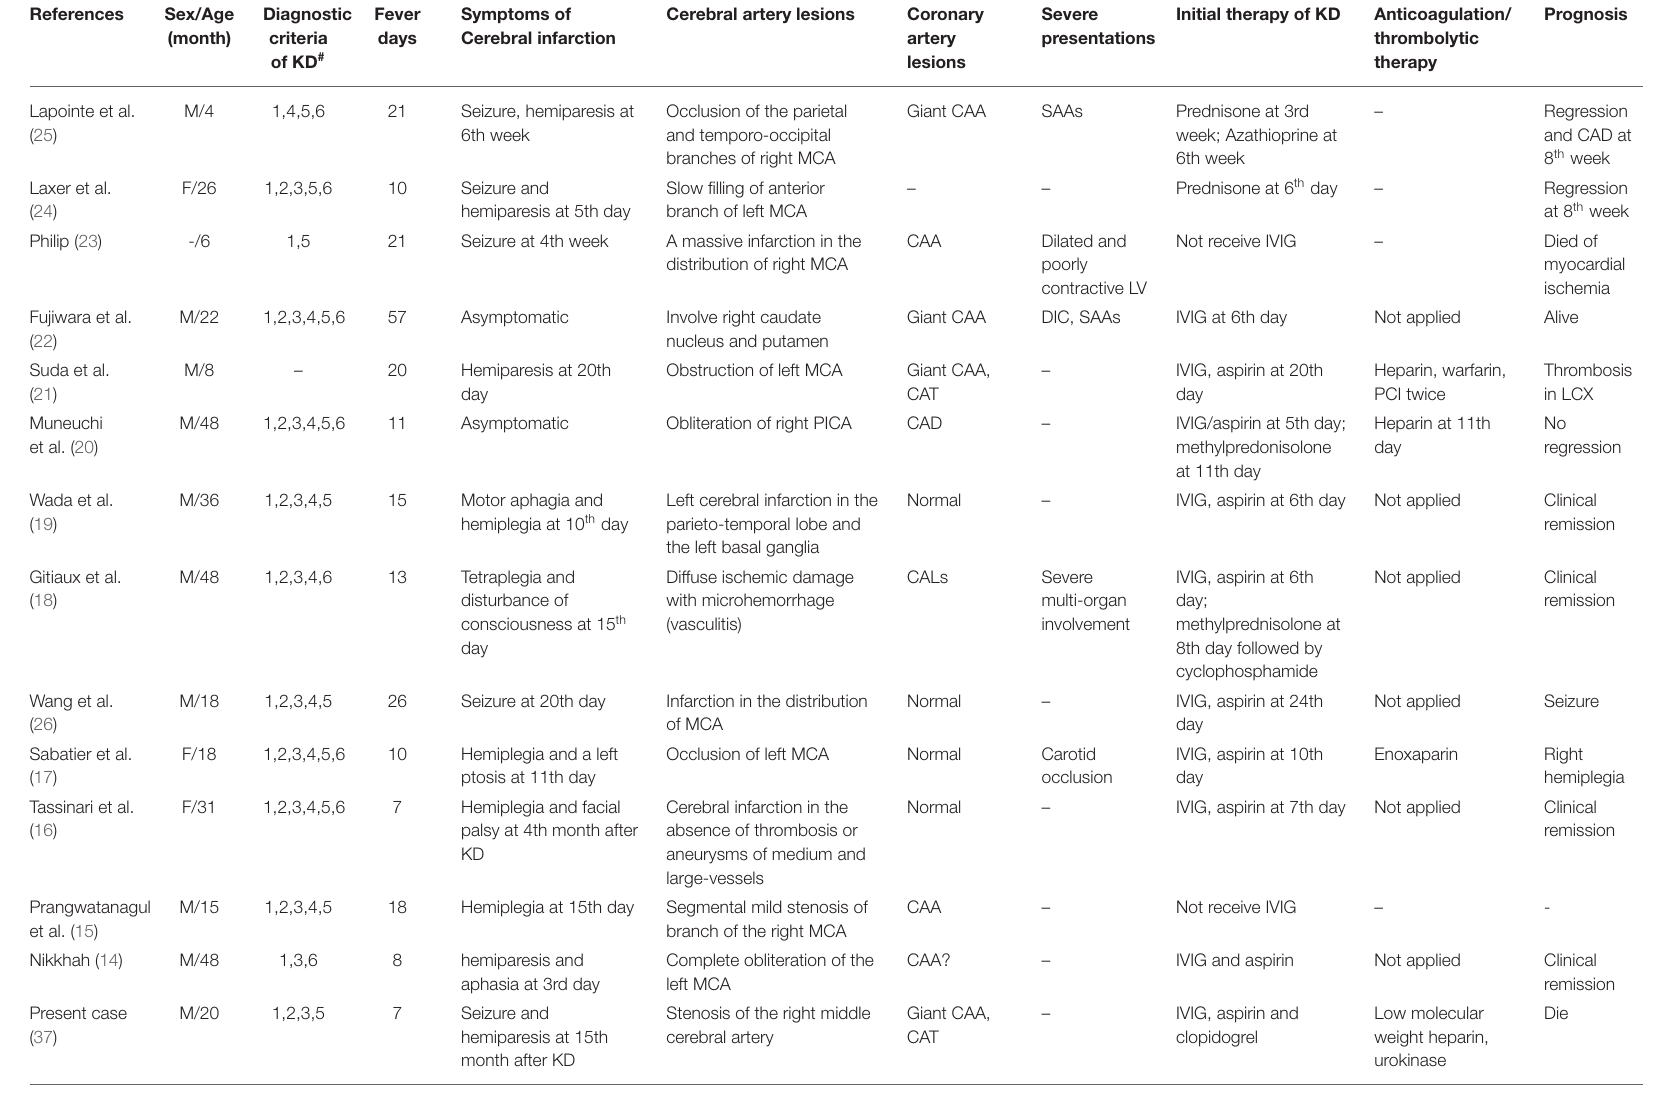
# DiagnosticcriteriaofKDincludes1.Feverforatleast5days;2.Bilateralbulbarconjunctivalinjectionwithoutexudate;3.Changesinlipsandoralcavity;4.Changesinextremities;5.Polymorphousexanthem;6.Cervicallymphadenopathy. CAA, coronary artery aneurysms; CAT, coronary artery thrombosis; MCA: middle cerebral artery; M, male; F, female; KD, Kawasaki disease; IVIG, intravenous immunoglobulin; SAA, systemic artery aneurysms; DIC, disseminated intravascular coagulation; PICA, posterior inferior cerebellar artery; LV, left